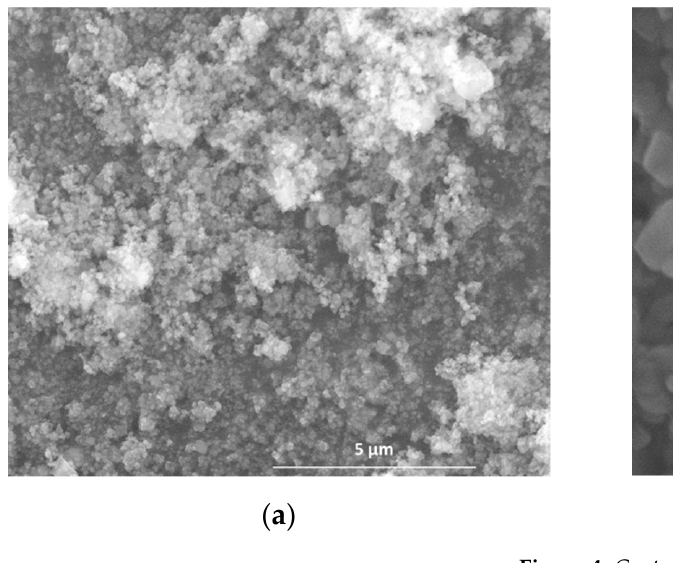
Figure 3. Thermal analysis of dried powders CC0.5, CC3.7 and CC7.4. The morphology of calcium carbonate crystals was also assessed by high resolution transmission electron microscopy (HR-TEM), as shown in Figure 5. This method permits an assessment of the total conversion of Ca(OH) 2 nano-grains in calcium carbonate, irre- spective of the initial concentration in nano-CaO of the starting suspension (Figure 5b,d,f); the size of crystals assessed by HR-TEM starts in tens of nanometers (for CC0.5—Figure 5a) and increases with the initial concentration of Ca(OH) 2 aq. susp., reaching hundreds of nanometers for CC3.4 and CC7.4 (Figure 5c,e).